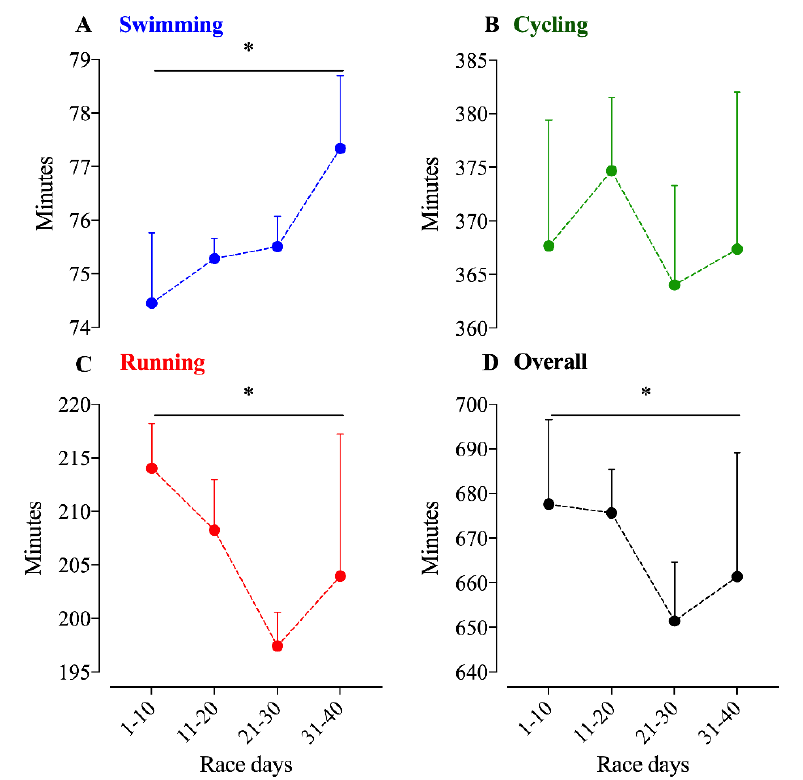
Figure 1. Ten-day average times of swimming, cycling, running, and overall time in 40 Ironman-distance triathlons. *: statistical significance ( p < 0.05) for time-effect. ( A ): Swimming time; ( B ): Cycling time; ( C ): Running time; ( D ): Overall time.